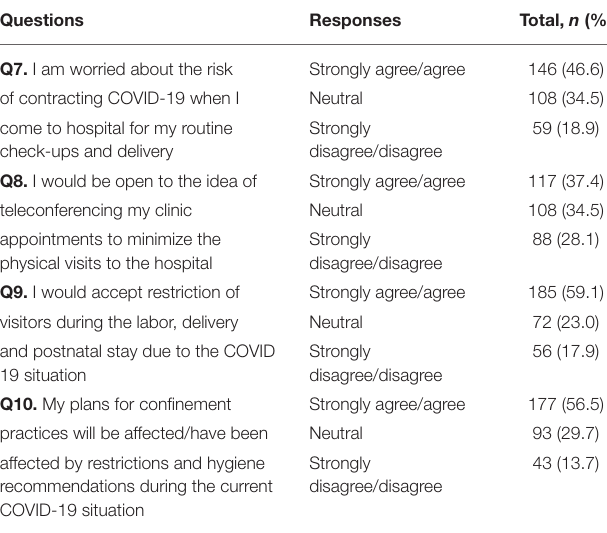
TABLE 3 | Expectations of perinatal and neonatal care during the current COVID-19